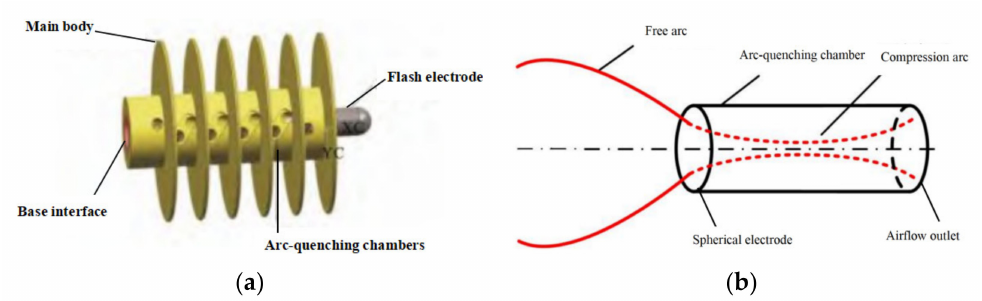
Figure 1. Structural schematic diagram of the multi-chamber arc-quenching arrester (MCAA). ( a ) The structural schematic diagram of the MCCA. ( b ) The structure of the arc-quenching